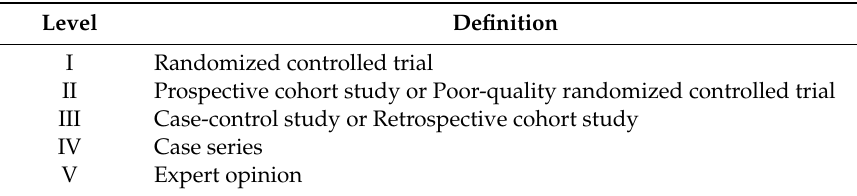
Table 2. Level of